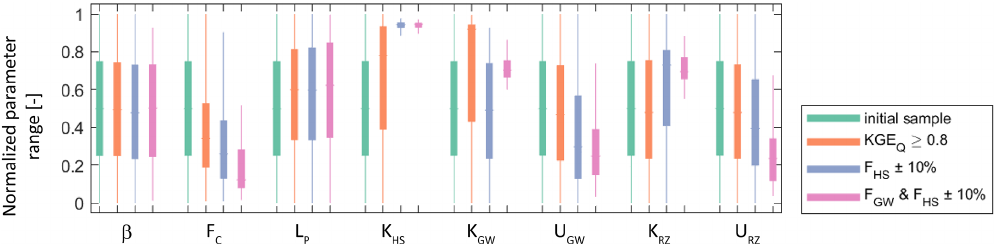
Figure 9. Initial parameter distribution and their modification along the three parameter estimation steps for the individual years 2013 and 2014, in addition to both years together. Boxes indicate the range between the 25th and 75th percentiles, and the lower and upper whiskers show the 5th and 95th percentiles,